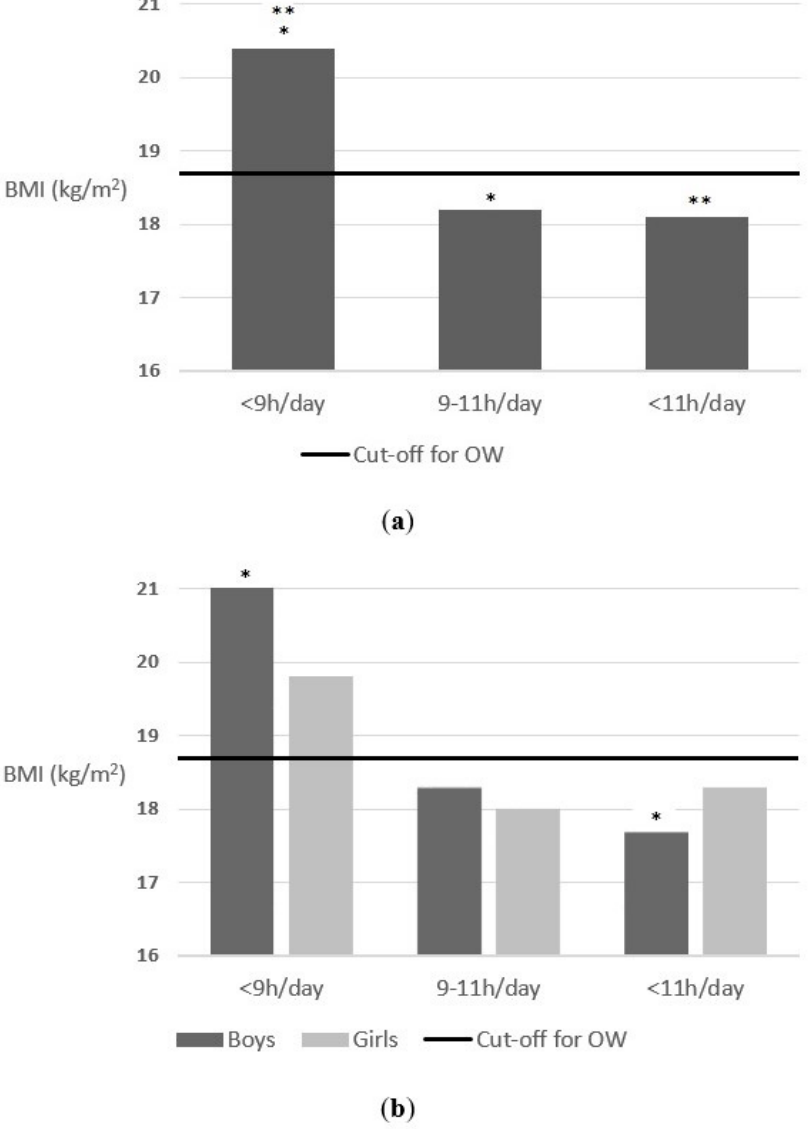
Figure 3. ( a ) Association between hours of sleep a day on weekends and body weight status (parents reported); ( b ) Association between hours of sleep a day on weekends and body weight status (par ‐ ents reported) segmenting by sex. The cut ‐ off for OW line indicates the beginning of the OW cate ‐ gory according to Cole’s cut ‐ off points [44]. * p ‐ value < 0.05 and ** p ‐ value <